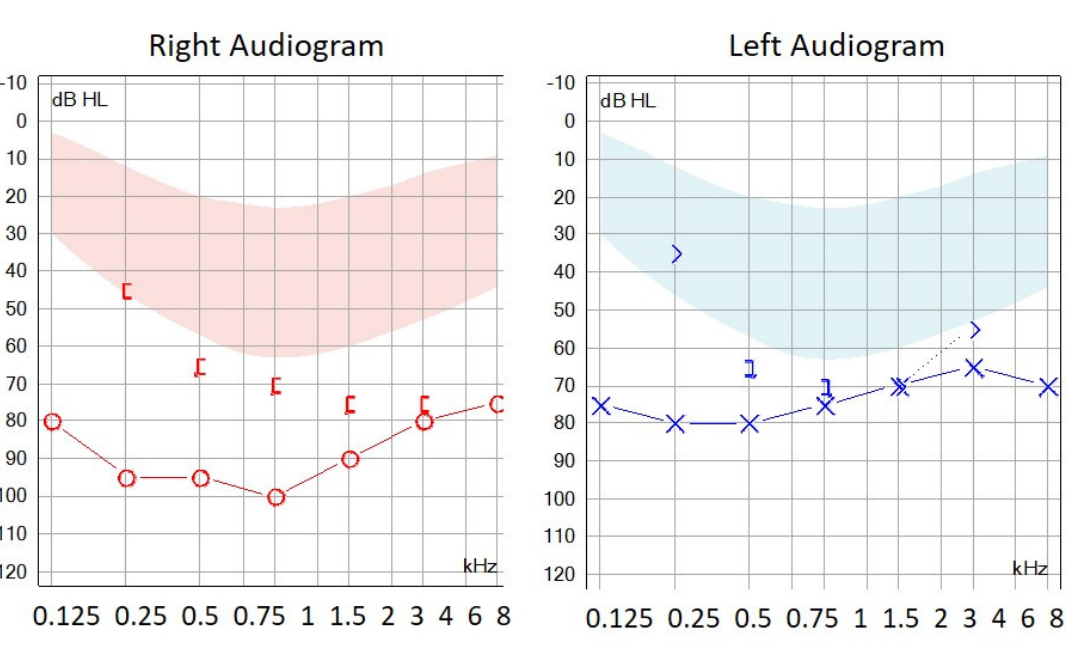
Table 4. Patients with only One Heterozygous Pathogenic or Likely Pathogenic Variant in Genes Associated with an Autosomal Recessive Inheritance Pattern.